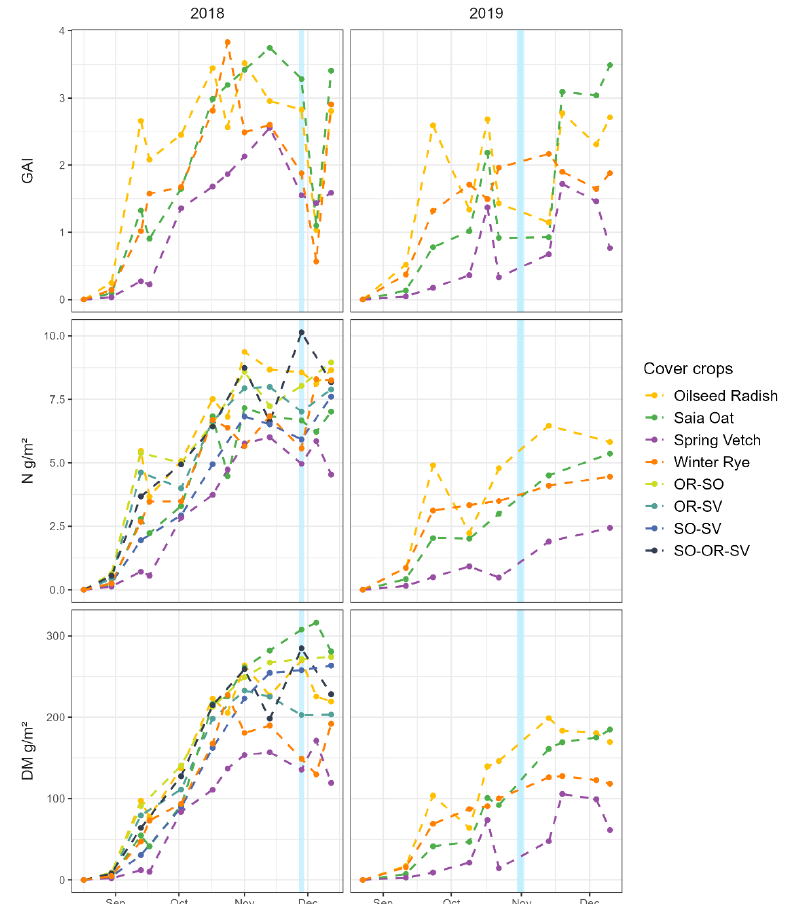
Figure 3. Biomass establishment of sole cover crops and mixtures (OR: oilseed radish, SO: saia oat, SV: spring vetch) presented by green area index (GAI), N uptake (g m − 2 ), and dry matter (DM) (g m −2 ). Blue vertical lines highlight frost events (28 November 2018, 31 October 2019, 1 November 2019). Point: sampling date; dashed line: linear interpolation between sampling dates.